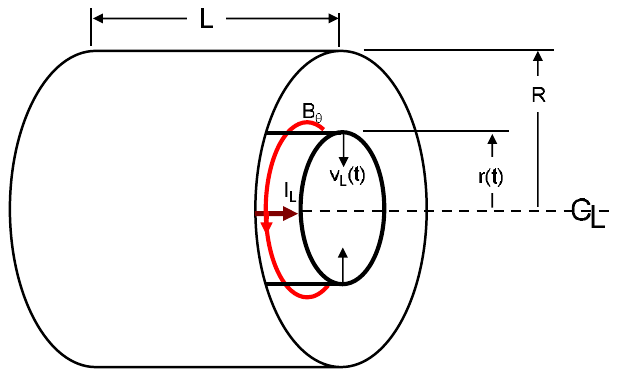
FIG. 11. (Color) Schematic of the imploding liner model used to model the time-dependent impedance of the z -pinch load. An is created by the current I flowing azimuthal magnetic field B (cid:1) L in the liner. The magnetic field generates a force that accelerates the annular mass radially inward with time-dependent velocity v L d (cid:11) L (cid:2) t (cid:3) (cid:4) (cid:2) t (cid:3) I (cid:2) t (cid:3)(cid:12) ; V L L L dt and this constitutes the reflected wave voltage due to the changing load impedance in the PIC simulation.